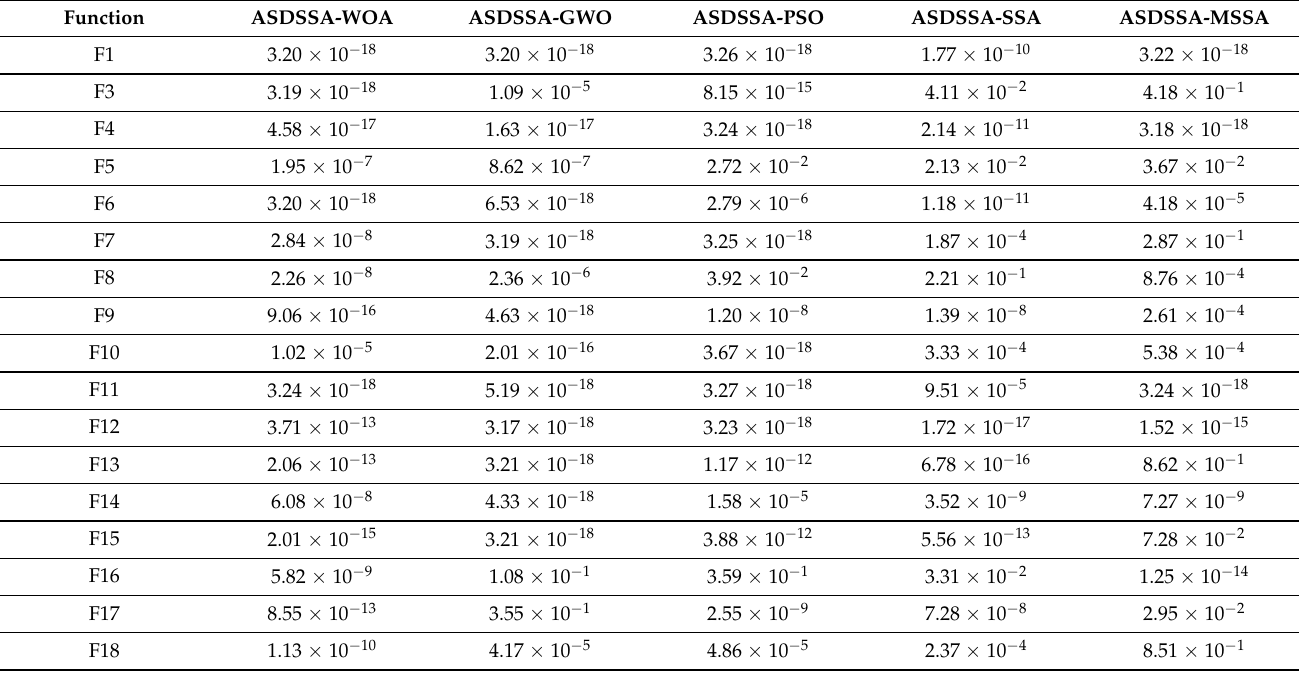
Table 9. Wilcoxon rank-sum test